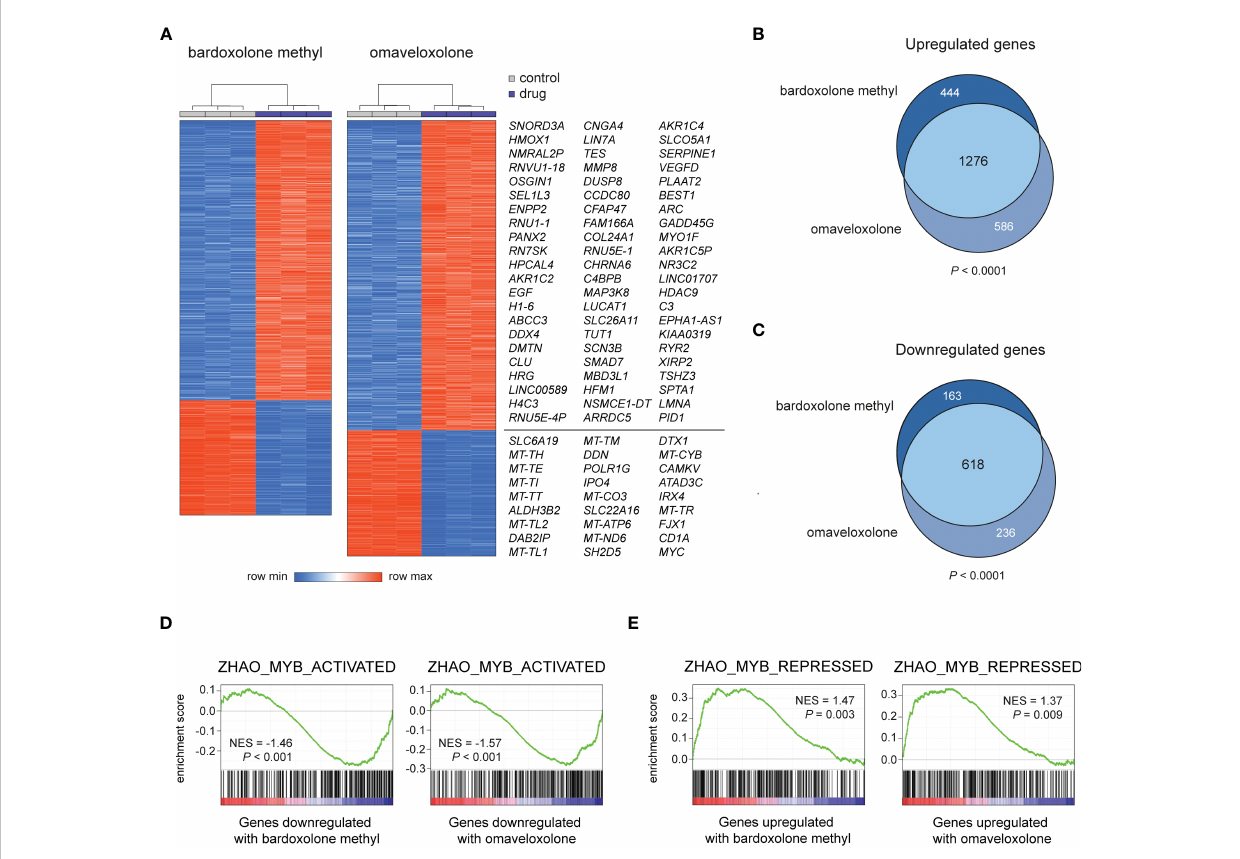
FIGURE 3 RNA-seq analysis of OT treated T-ALL cells. (A) Hierarchical clustering and heatmap analysis of global gene expression data from MOLT-4 cells treated for 24 h with 375 nM OTs. The most up- and downregulated genes by both drugs are shown to the right. (B, C) Venn diagrams of up- and downregulated genes in OT treated T-ALL cells. The signi fi cance of overlap was estimated by chi-square tests. (D, E) Gene set enrichment analysis of MYB-activated and repressed genes in OT treated T-ALL cells. NES, normalized enrichment